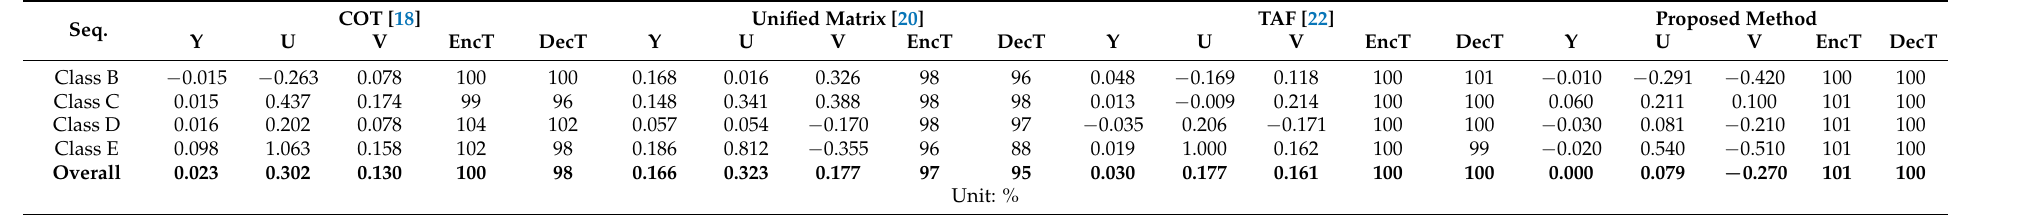
Table 5. Comparison of the overall simulation results for the derivation of transform kernels with the proposed method